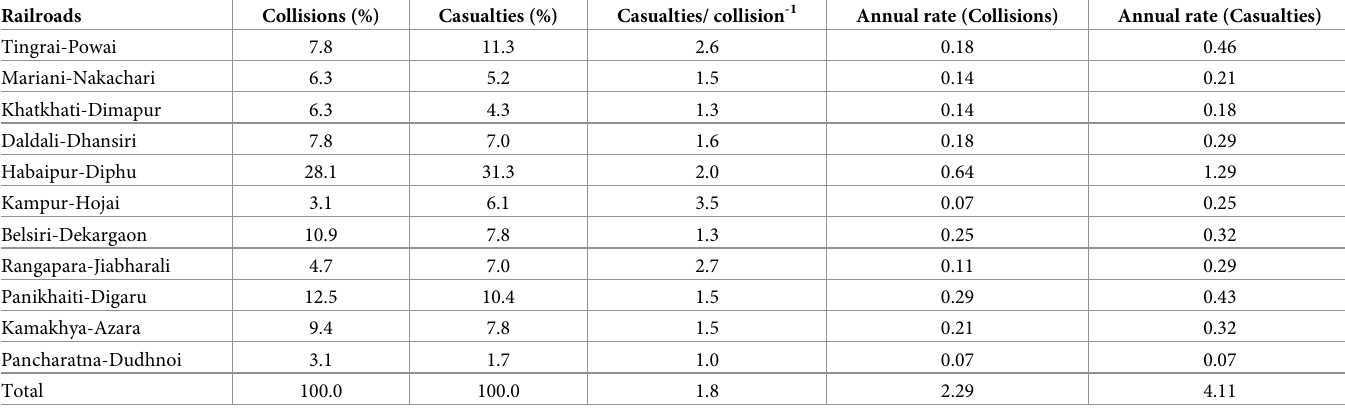
Table 3. Elephant-train collisions and casualties in the sample railroads, 1990–2018. Railroads